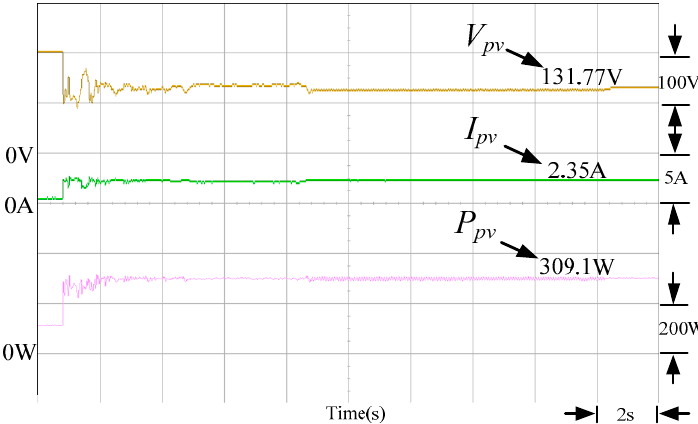
Figure 9. Output P–V curve of Case 2 photovoltaic module array.